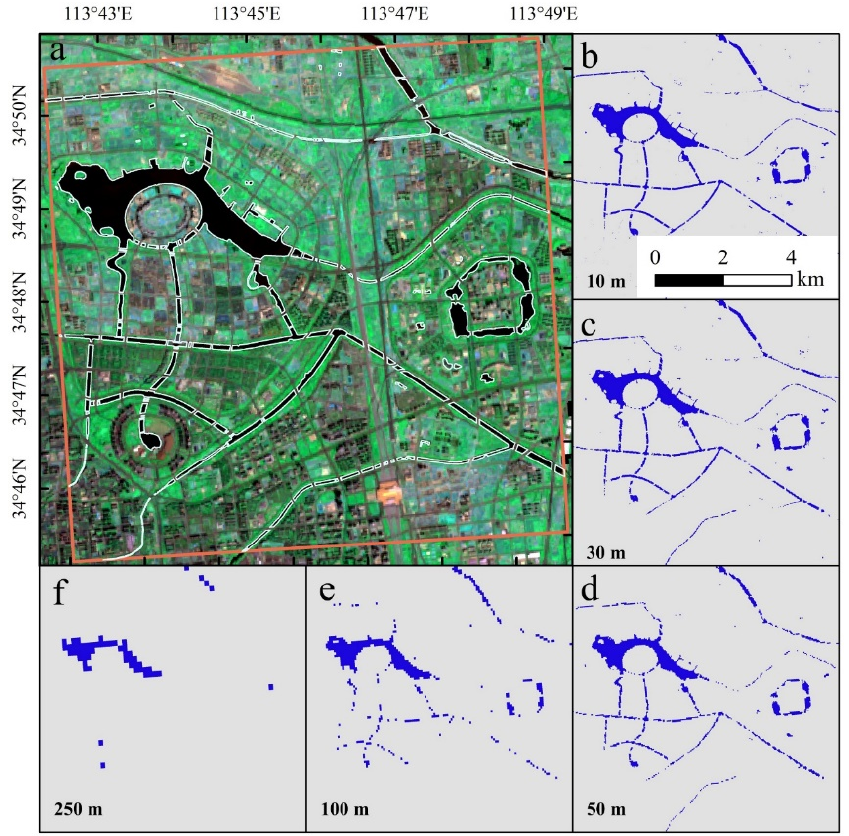
Figure 13. Scale effect in experimental area A: ( a ) white lines in remote-sensing image indicate real surface water boundaries, ( b ) water area extracted using Sentinel-2A 10m-resolution data, ( c ) water area extracted using Landsat-8 30m-resolution data, ( d ) water area resampled to 50 m from Sentinel-2A 10m-resolution data, ( e ) water area resampled to 100 m from Sentinel-2A 10m-resolution data, and ( f ) water area extracted using MODIS 250-resolution data.